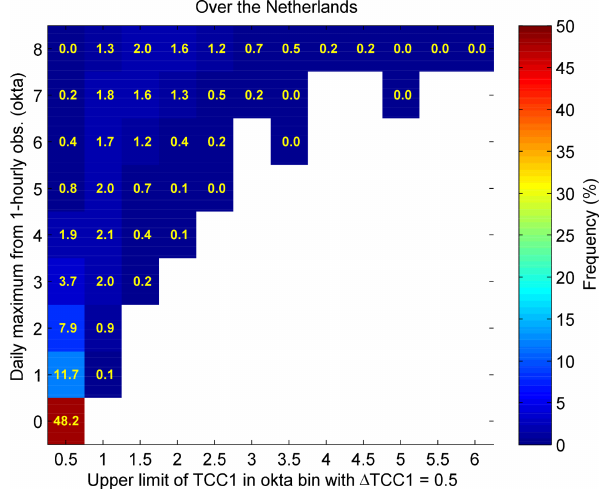
Figure 5. Monthly climatology of burning thresholds for five se- lected stations.